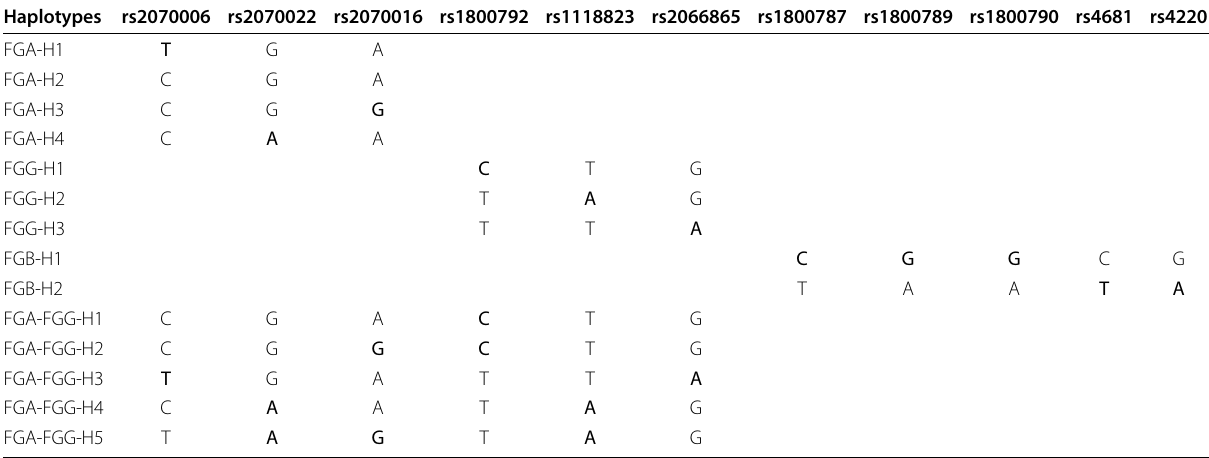
Table 4 Haplotypes for FGA, FGB, FGG and FGA-FGG gene SNPs with frequencies >5%.